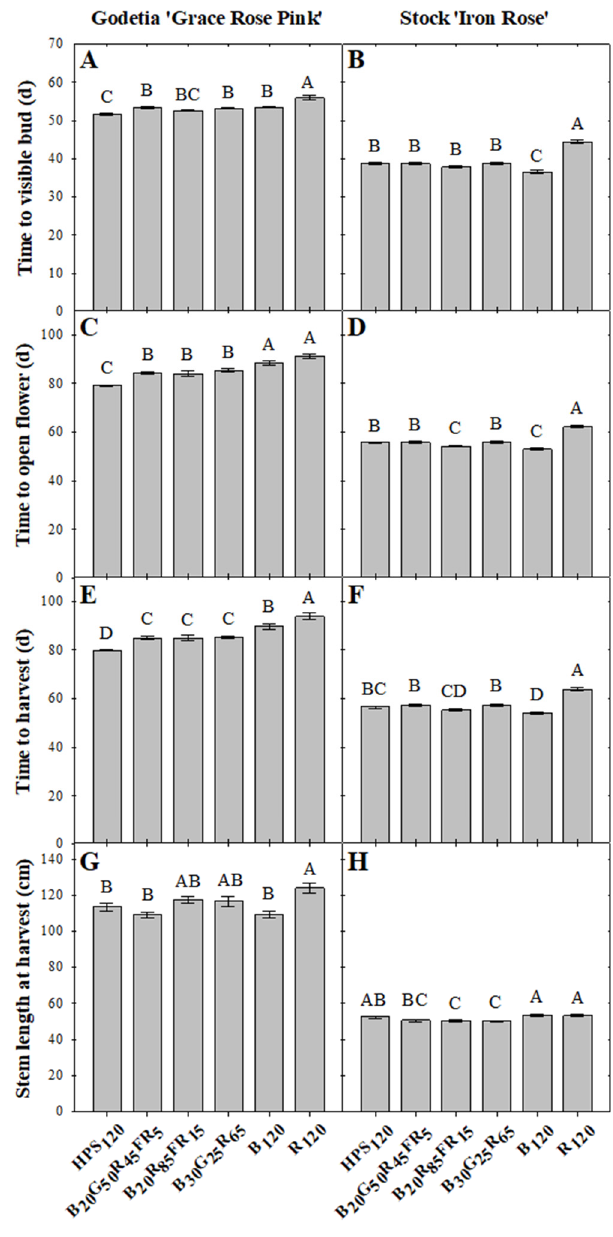
Figure 2. ( A , B ) time to visible flower bud, ( C , D ) time to open flower, ( E , F ) time to harvest, and ( G , H ) stem length at harvest of godetia ‘Grace Rose Pink’ and stock ‘Iron Rose’ in response to SL spectrum, pooled over two replications. SL treatments consisted of either 460 W HPS fixtures (HPS120; LR48877; P.L. Light Systems, Beamsville, ON, Canada), 631 W LED fixtures (B20G50R45FR5; VYPR 2p; Fluence, Austin, TX, USA), 325 W LED fixtures (B20R85FR15; LumiGrow Pro 325; LumiGrow, Emeryville, CA, USA), 600 W LED fixtures (B30G25R65; LX601G, Heliospectra, Göteborg, Sweden), a combination of 72 W LED fixtures (B120; HortiLED MULTI, P.L. Light Systems) and 625 W LED fixtures (R120; LumiGrow Pro 650E, LumiGrow), or 625 W LED fixtures (LumiGrow Pro 650E; LumiGrow). Means not followed by the same letter are significantly different by Tukey–Kramer honestly significant difference (HSD) test at p ≤ 0.05. Bars represent the mean and error bars indicate standard